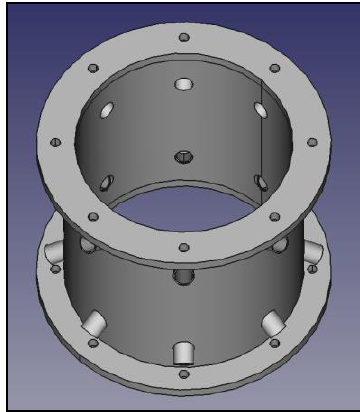
Fig. 6. The gauge